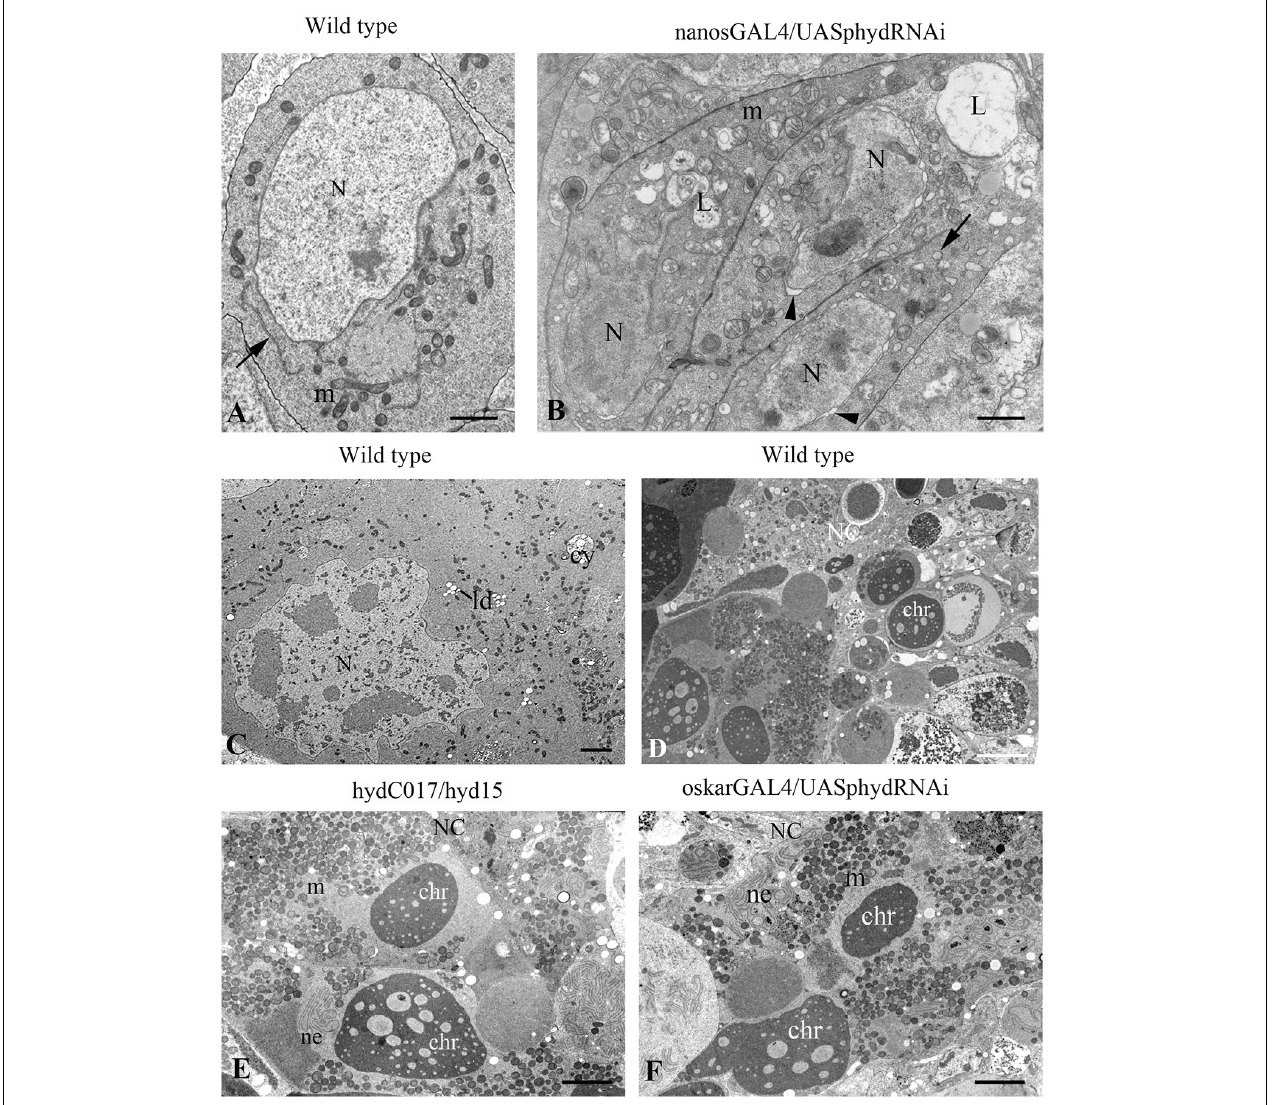
FIGURE 4 | Ultrastructural features of germ cell death in hyd -RNAi ovaries. (A–B) Electron micrographs of primordial GCs in wild-type and nanos-GAL4/UAS-hyd -RNAi ovaries at the third instar larva stage. (A) A wild-type GC with morphology typical of this stage: nuclei with smooth contours, evenly dispersed chromatin, and distinct nucleoli; the cytoplasm contains round or oval mitochondria, endoplasmic-reticulum cisterns (ER cisterns), Golgi complexes, and abundant ribosomes. (B) GCs with signs of intracellular degradation: condensation of the nuclear matrix, curvature of the nuclear outline, nuclear envelope dilation (arrowheads), mitochondrial swelling, ER vacuolization (arrows) and numerous lysosomes. N, nucleus; m, mitochondrion; L, lysosome. Scale bar: 1 µ m. (C–F) Signs of mid-oogenesis cell death in a wild-type, hydC015/hyd15 and oskar-GAL4/UAS-hyd -RNAi ECh. (C) A segment of a mid-oogenesis ECh before cell death. Nurse cell ultrastructure without structural anomalies or signs of degradation. (D–F) Morphology of a dying ECh in a wild-type (D) , hydC015/hyd15 (E) , and oskar-GAL4/UAS-hyd -RNAi (F) . Nurse cell cytoplasm contains condensed chromatin material, aggregates of nuclear-envelope fragments and clusters of mitochondria, numerous lysosomes. In the nurse cell area, there are of varying content present in this layer. NC, nurse cell; N, nucleus; m, mitochondrion; chr, chromatin; ne, nuclear envelope. Scale bar: 5 µ